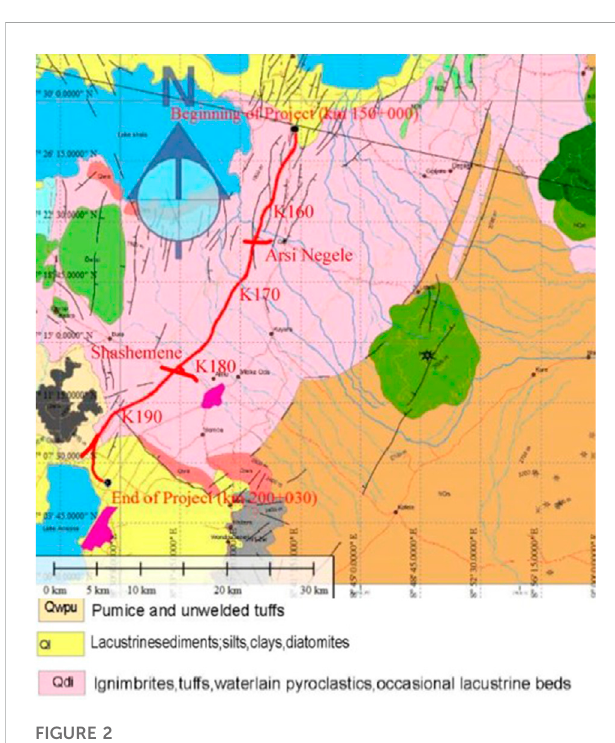
FIGURE 2 Geographical location map of the MH